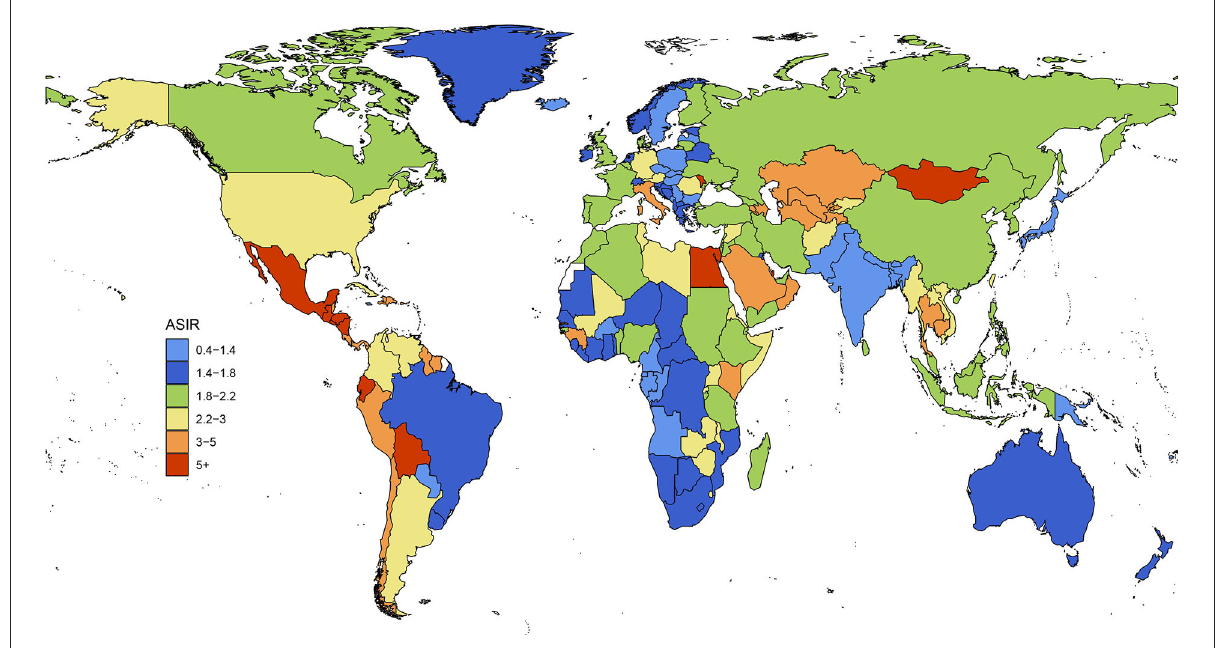
FIGURE4 Differences in ASIR between different geographical